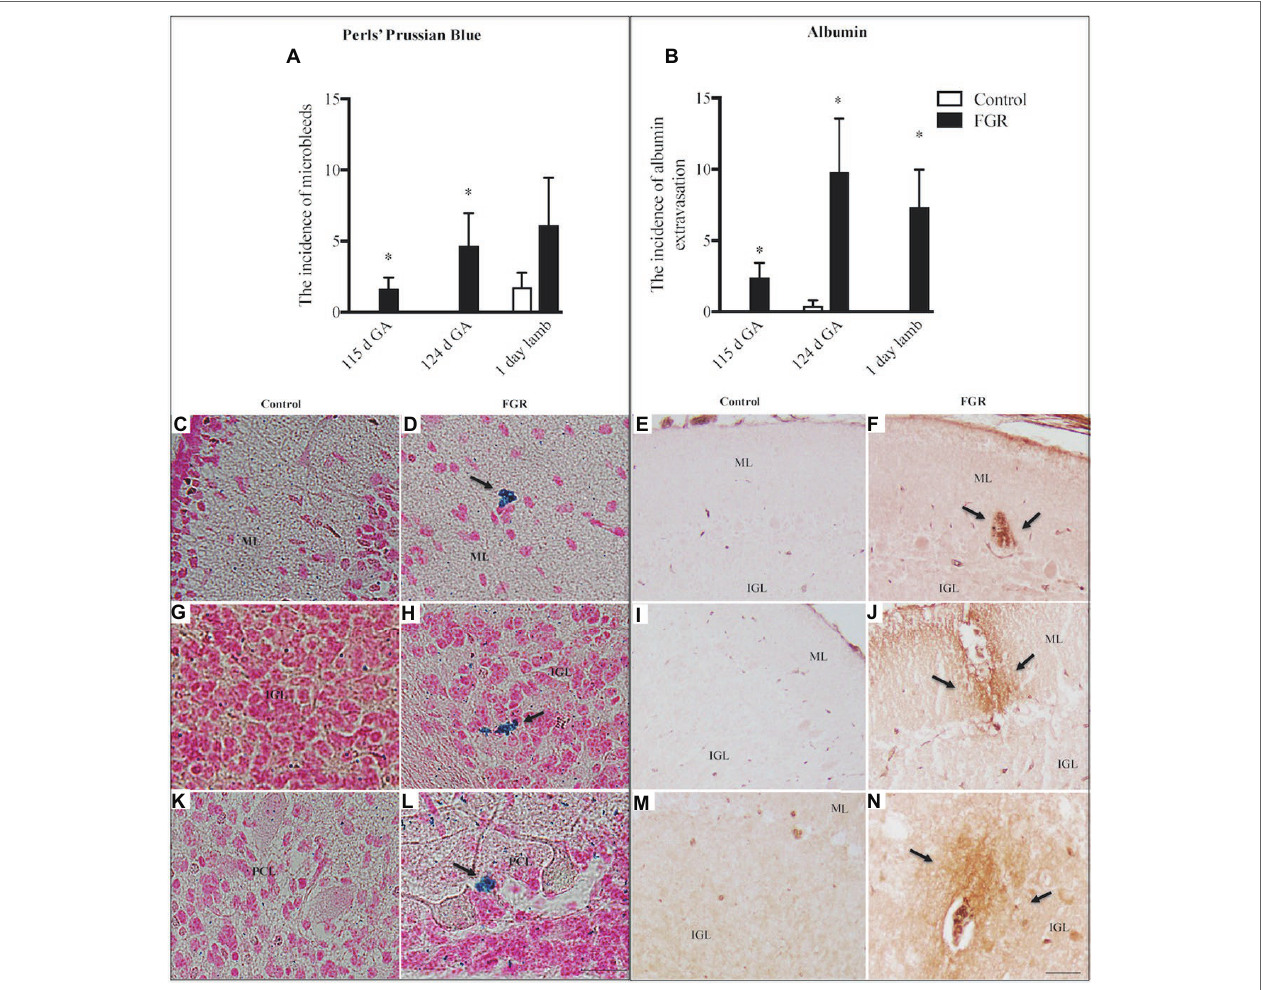
FIGURE 2 | The number of microbleeds (A) and albumin extravasation from blood vessels (BVs) (B) in the cerebellum of the fetal brain at 115 d GA, 124 d GA, and 1-day-old lamb of control and FGR animals. Each bar represents the mean ± SEM; * p ≤ 0.05 versus control. Representative micrographs showing Perls’ Prussian Blue staining and albumin immunohistochemistry in a 115 d GA fetus (C–F) , 125 d GA (G–J) , and 1–day-old lamb (K–N) brains. Microbleeds were visualized as bright blue patches that were counter-stained with nuclear fast red. Arrows indicate the sites of microbleeds/albumin extravasation. FGR, fetal growth restriction; PCL, Purkinje cell layer; ML, molecular layer; IGL, internal granular layer. Scale bar for Perls in (L) = 25 μm. Scale bar for albumin in (N) = 50